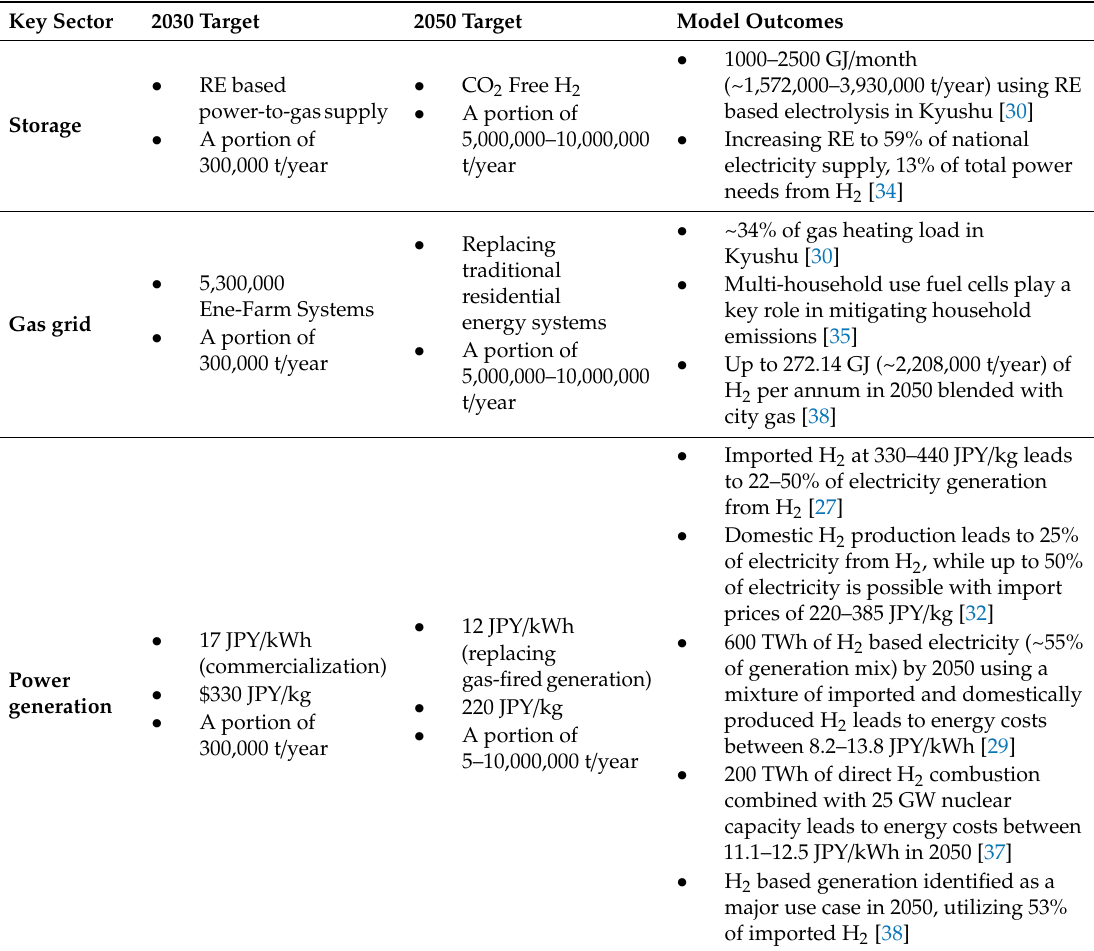
Table 3. Model Outcomes and Hydrogen Strategy Target